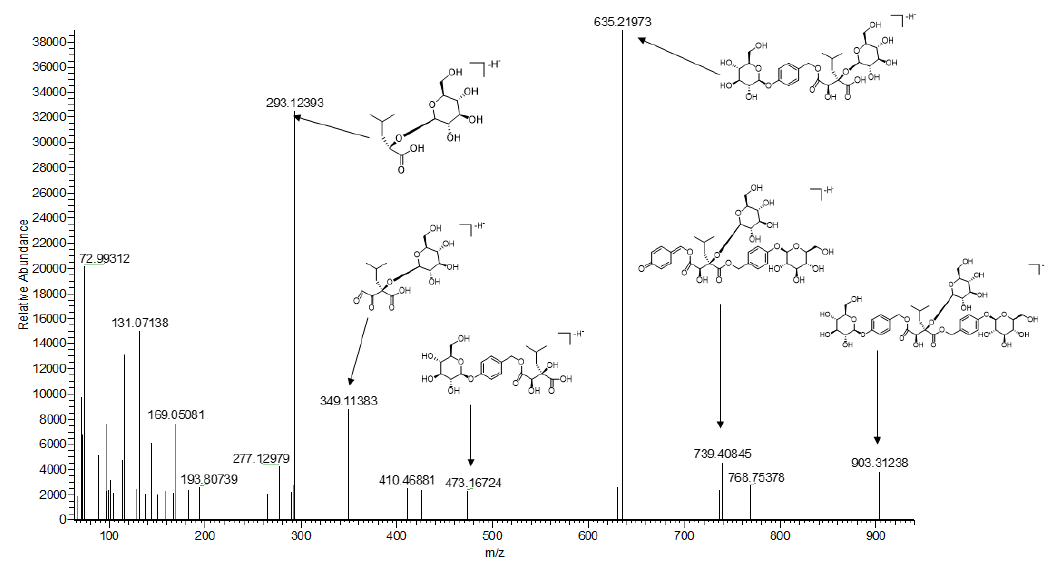
Figure 3. The possible fragmentation mechanism of dactylorhin B.